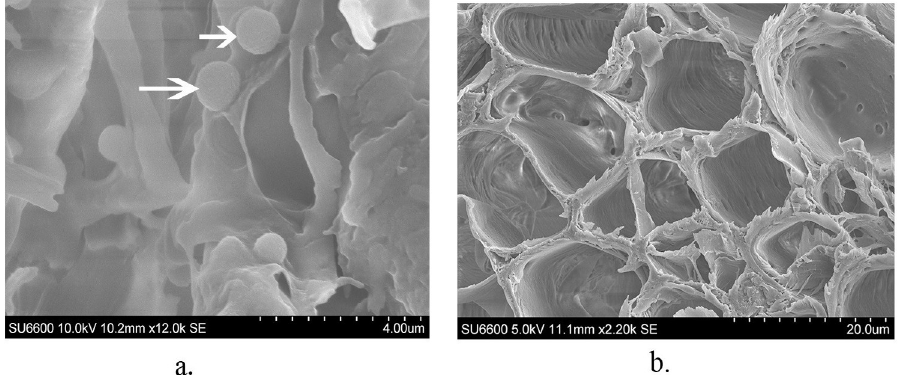
Fig 6. Scanning electron micrographs of transverse sections of phloem tissue (a) infected with WCLWD associated phytoplasma (b) of non-infected, coconut pinnae mid rib samples devoid of such phytoplasma bodies . Spherical, pleomorphic (200–1000 nm) phytoplasma bodies are visible, attached to the inner surface of the cellular membrane of the infected sieve elements (indicated by arrows).